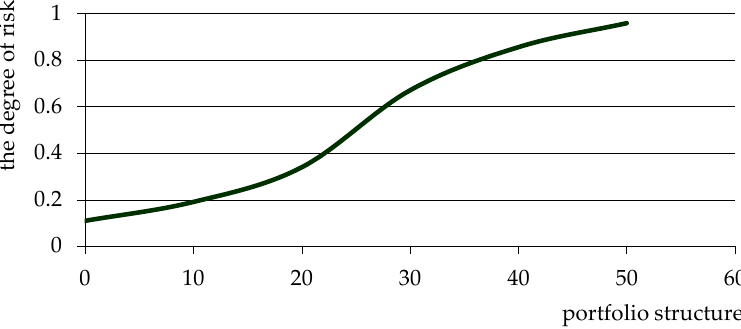
Figure 4. Dependence “portfolio structure-the extent of risk”.